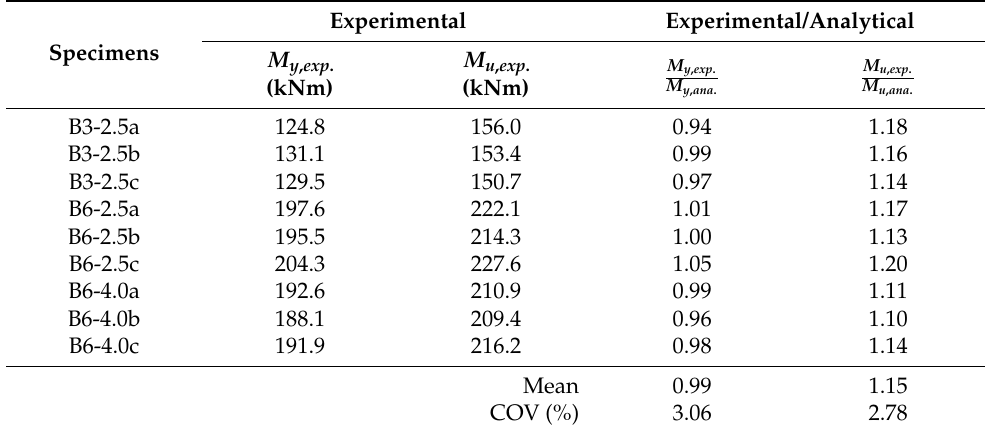
Table 4. Comparison of experimental and analytical results for flexural